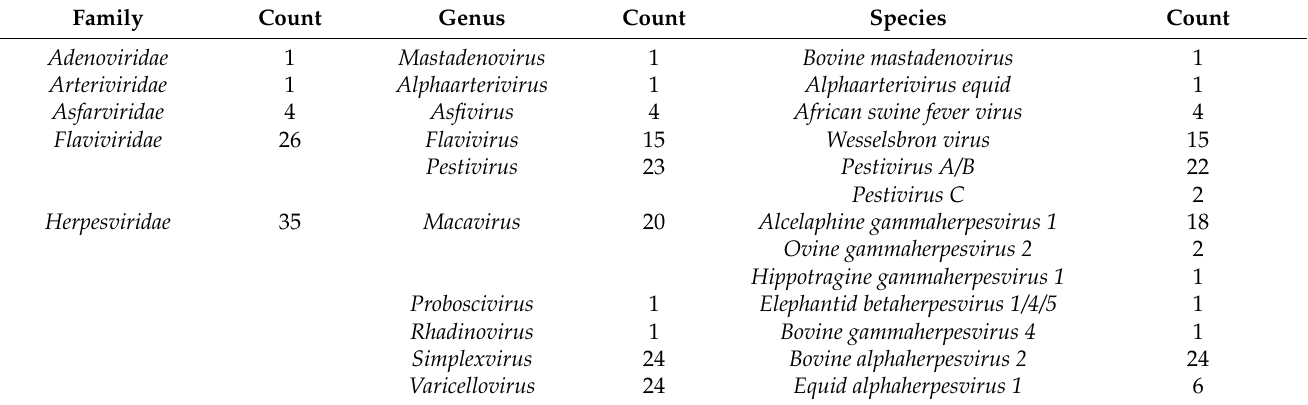
Table 6. The number of African ungulate species affected by a virus family/genus/species.